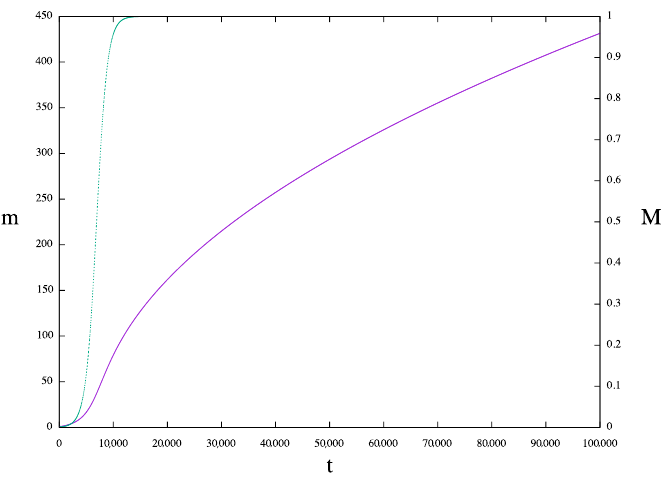
Figure 12. Plot of the average value of the maximum height of corpus (approximating the corpus site) m ( t ) versus time t (continuous line), and the logistic growth of the user base M ( t ) (dotted line).